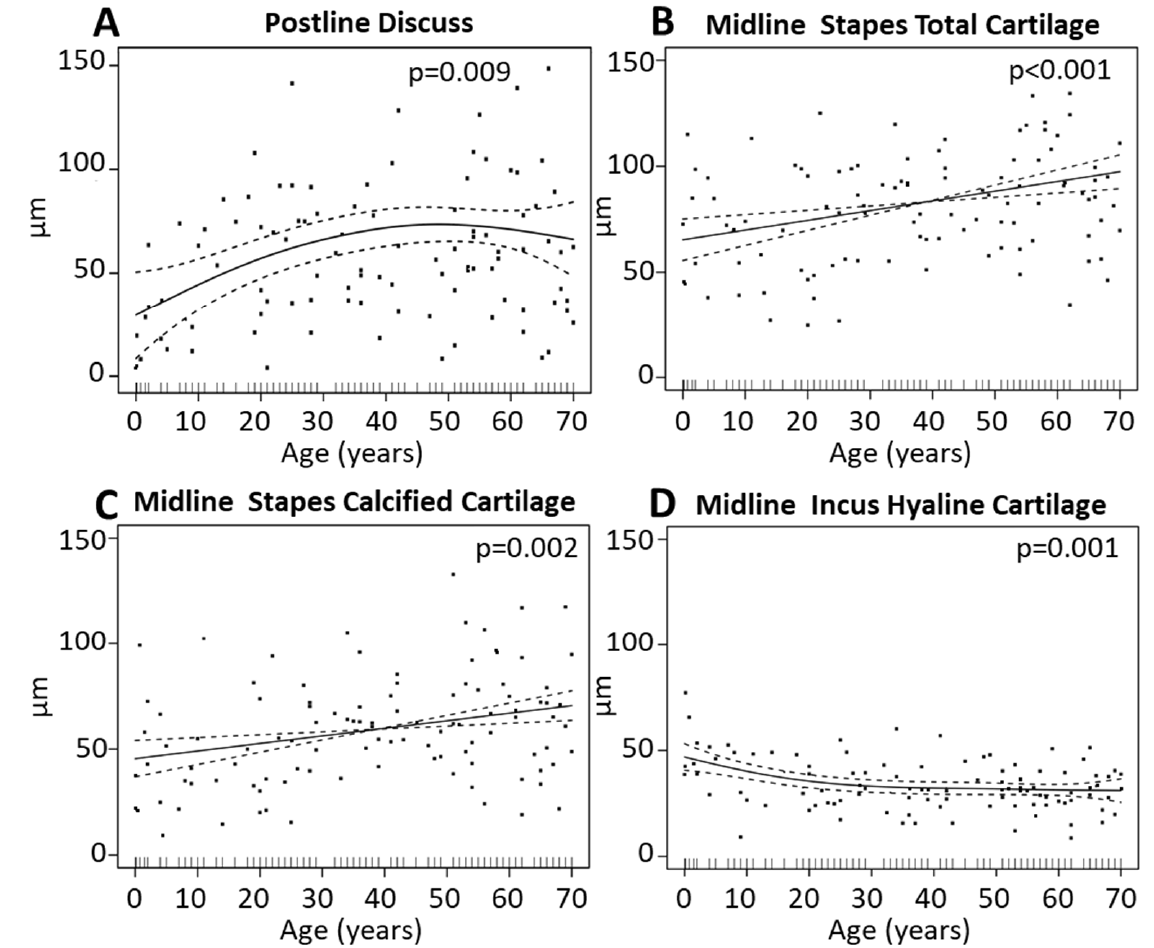
Figure 4. Incudo-stapedial joint (ISJ) geometrical variation with age. Indicated are generalized cross-validation optimal non-parametric regression curves (solid) of the significant parameters: ( A ) Postline Discus, ( B ) Midline Stap C tot, ( C ) Midline Stap cC, and ( D ) Midline Inc hC. The dotted lines form the 95% pointwise confidence intervals. The black dots represent single measurements. The black lines on the x-axis indicate the age of each individual.